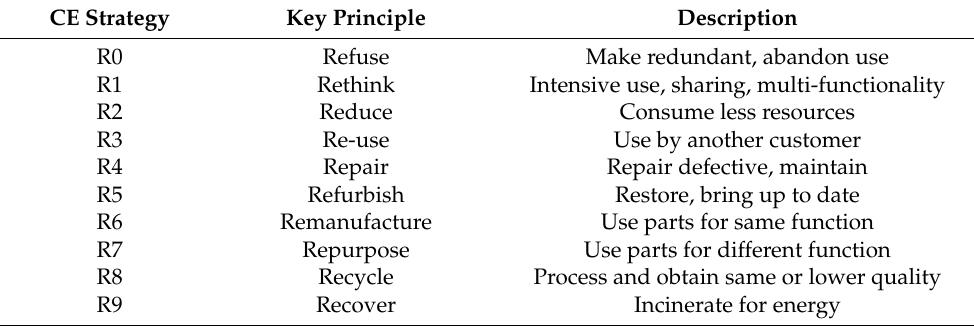
Table 1. 9R model of CE strategies adapted from Potting et al. (2016) [7]. CE